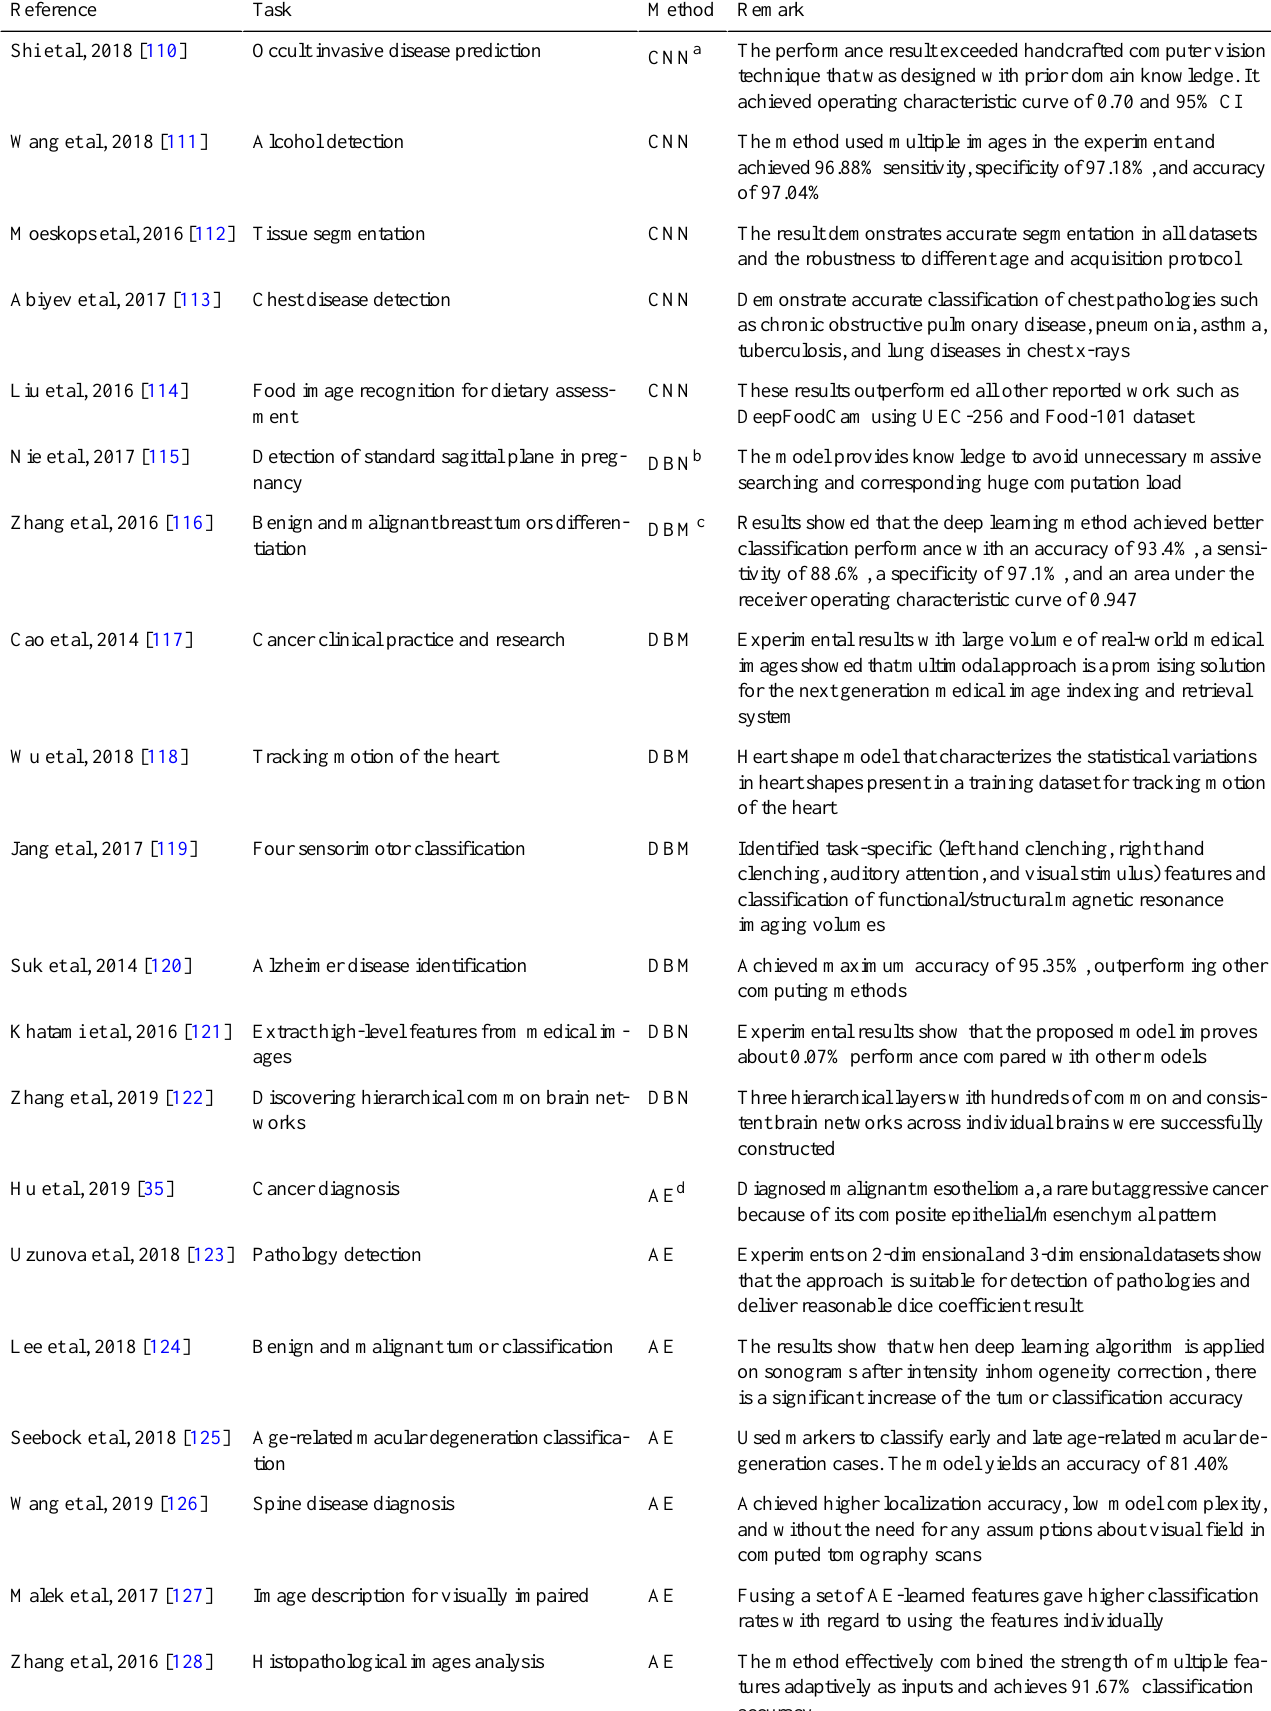
Table 3. Application of deep learning techniques in medical